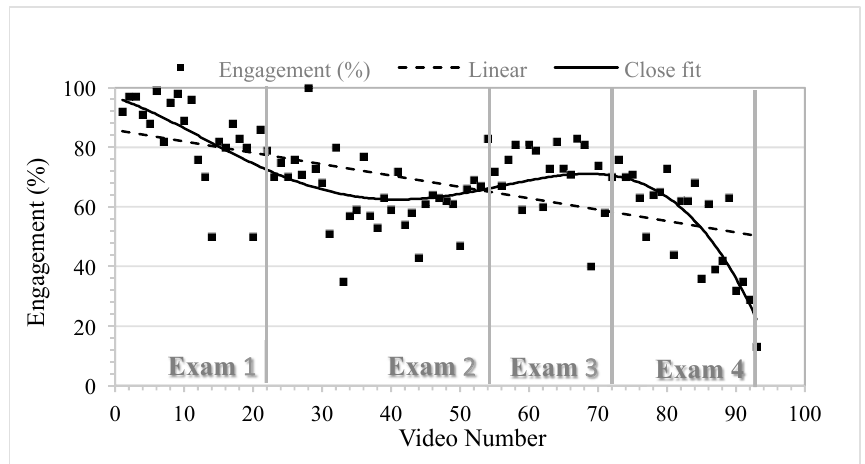
Fig. 1. Video Engagement plotted over chronological video order (vertical grey lines indicate last video before each